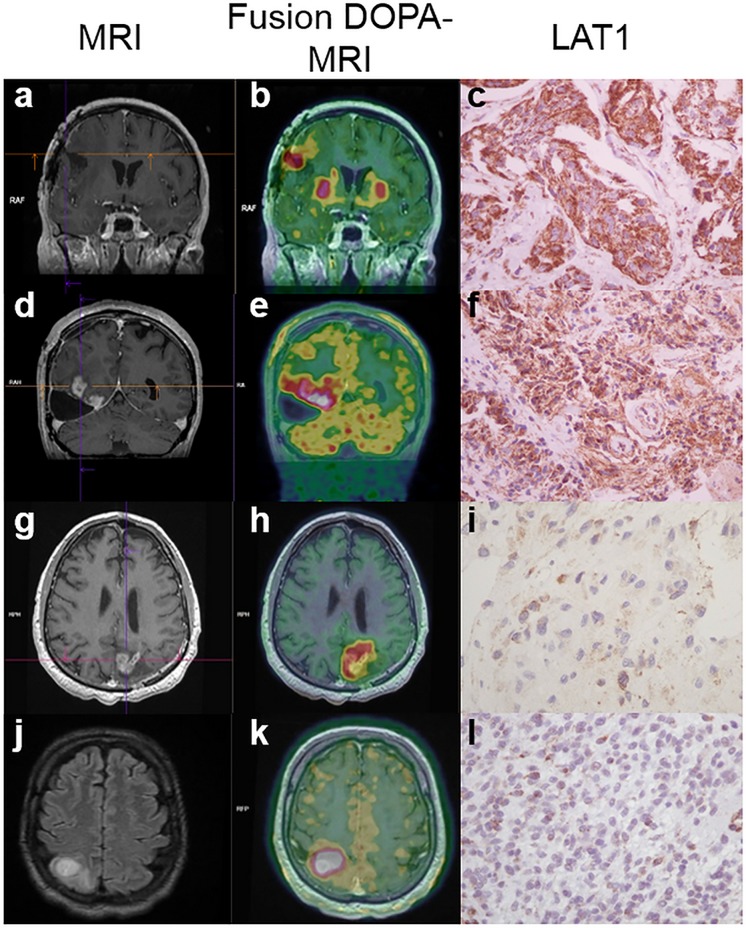
Illustration of LAT1 score and [18F] FDOPA PET in four cases: MRI (a,d,g,j), [18F] FDOPA-PET images fused with MRI (b, e, h, k) and LAT1 scores (c, f, i, l) of four cases are presented to illustrate the results. Case 20 (a, b, c) corresponding to a metastasis from breast carcinoma displayed a high SUVmax (6.18), a ratio SUVmax T/S of 1.24 and a high score of LAT1 expression (285). Case 28 (d, e, f) corresponding to a glioblastoma showed a high SUVmax (7.48), a ratio SUVmax T/S of 1.53 and a high LAT1 score (200). Case 8 (g, h, i) corresponding to a glioblastoma showed a high SUVmax (11.21), a ratio SUVmax T/S of 2.18 and a low LAT1 score (50). Case 22 (j, k, l) corresponding to a glioblastoma showed a high SUVmax (9.3), a ratio SUVmax T/S of 2.47 and a low LAT1 score (40).